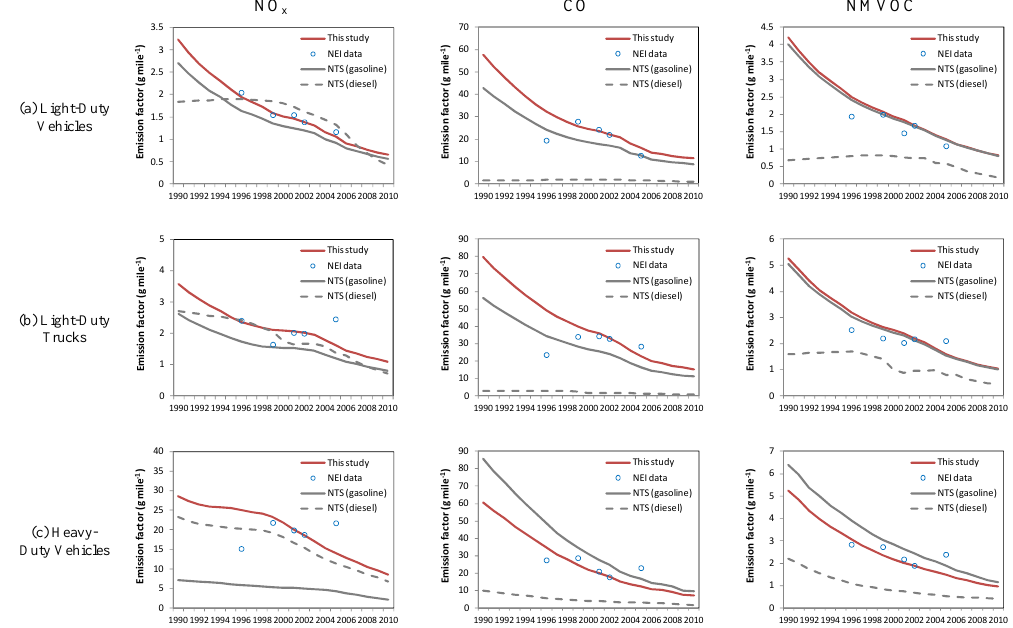
Fig. 4 On-road NO x , CO and NMVOC emission factors in this study (NTS-National Transportation Statistics) Fig. 4. On-road NO x , CO and NMVOC emission factors in this study (NTS – National Transportation